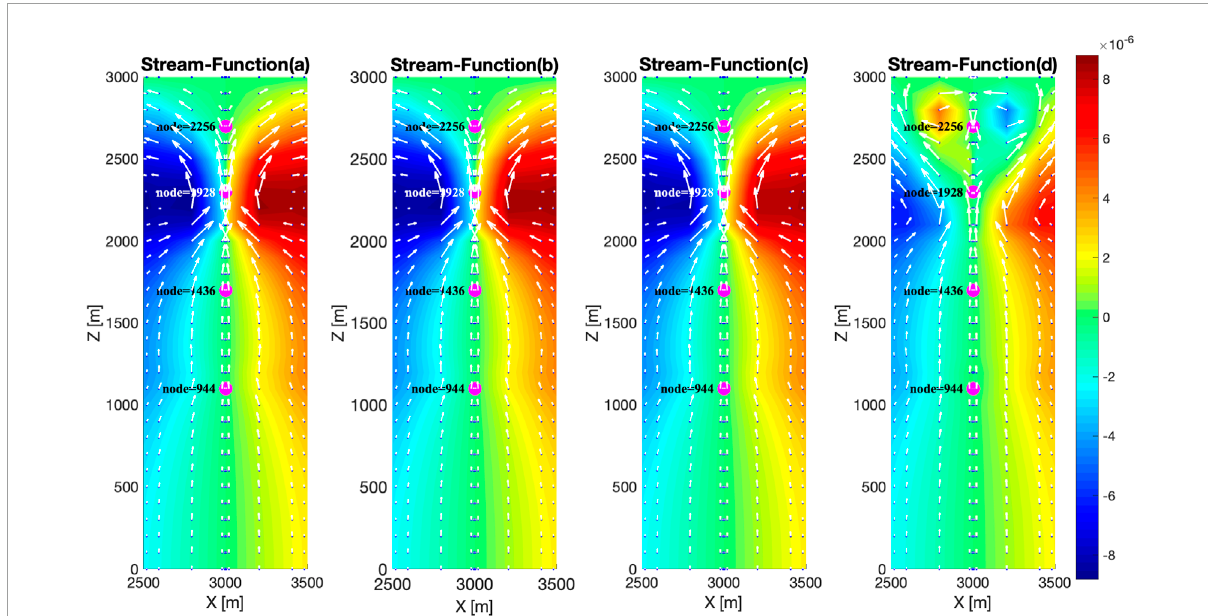
FIGURE 15 Stream function field’s time variation in the Phlegraean Fields with the DBHE in service. Results after 0.9 years (A) , 3 years (B) , 12 years (C) , and 200 years (D) .